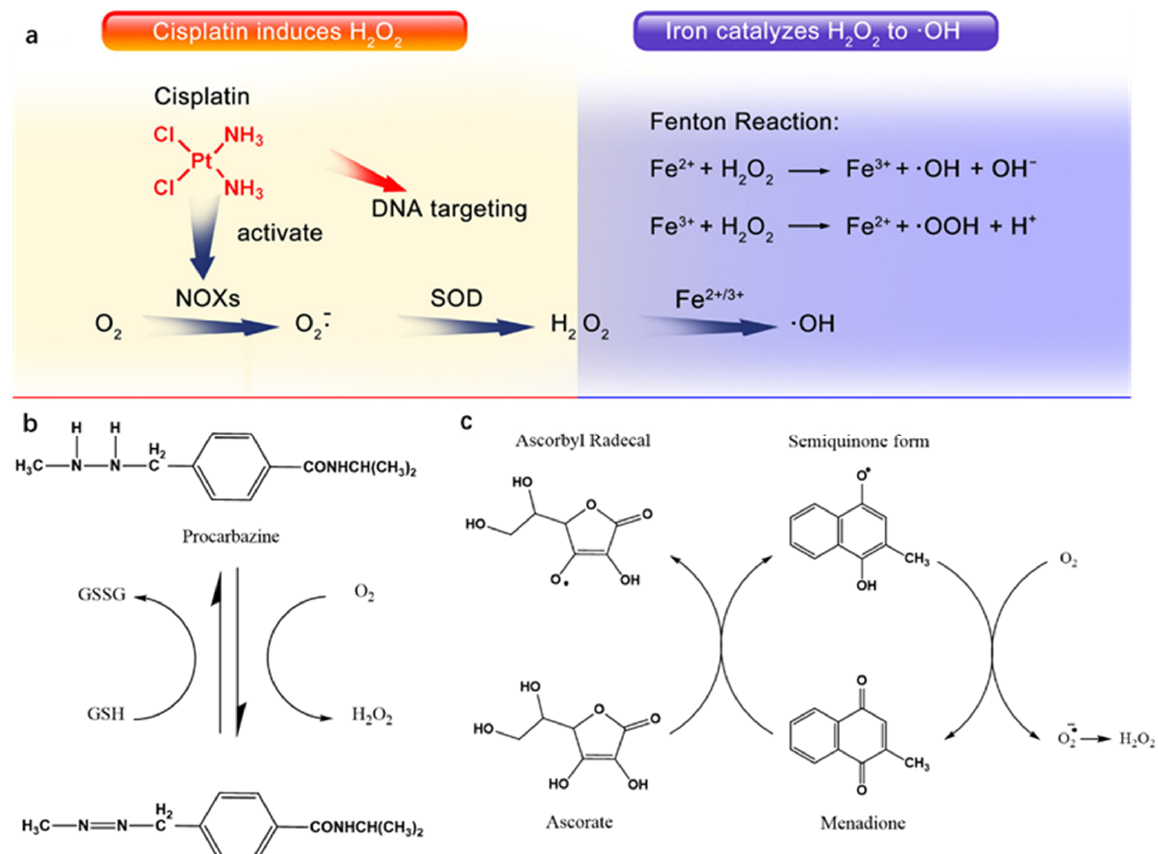
Figure 2. Mechanism of ROS generation by Pt, procarbazine, and menadione. ( a ) Cisplatin activates NOX, which catalyzes formation of superoxide and H 2 O 2 from O 2 ; iron catalyzes the Fenton chemistry to turn H 2 O 2 into highly toxic •OH; adapted from [48]. ( b ) Procarbazine oxidation to its azo derivative yields hydrogen peroxide; adapted from [50]. ( c ) H 2 O 2 is produced during the ascorbate-driven menadione redox cycling; adapted from [51].